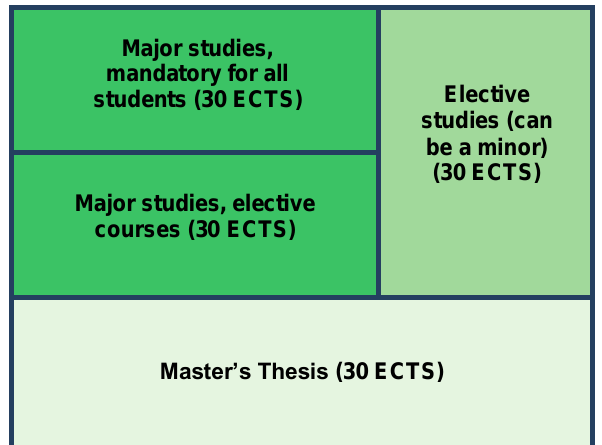
Figure 1. Programme structure. The project course is one of the elective major studies courses in the Master’s degree programme in geoinformatics. Students can select 30 ECTS from a pool of several courses.